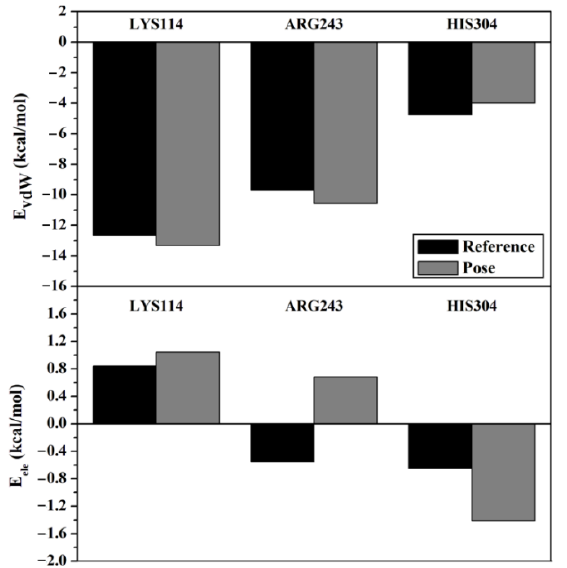
Figure 2. Footprint analysis of the primary amino acid residues responsible for the interaction between L-tartaric acid and phosphomannomutase/phosphoglucomutase.